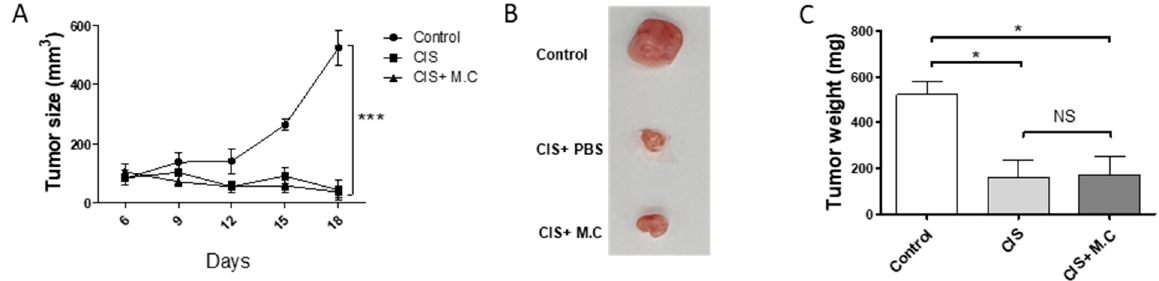
Figure 7. M.C does not interfere with cisplatin activity in tumors. CT26 tumor subcutaneous injections were administered in control, cisplatin (CIS), CIS+M.C (cisplatin+ M.C) treated mice. ( A ) Tumor size. Tumor volumes measured every 3 days using a caliper. Data are presented as the mean ± SEM ( n = 5). * p < 0.05, *** p < 0.001 vs. control, using a two-way ANOVA. Mice were sacrificed on day 18; ( B ) representative images of the tumors; ( C ) tumor weight measurement. Data are presented as the mean ± SEM ( n = 4/group). * p < 0.05, *** p < 0.001 vs. CIS+PBS, using a Bonferroni post hoc test after one-way ANOVA. NS = non-significant.